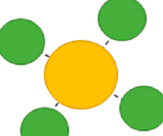
Increasing the HCl concentration in the aqueous phase decreases the extraction per ‐